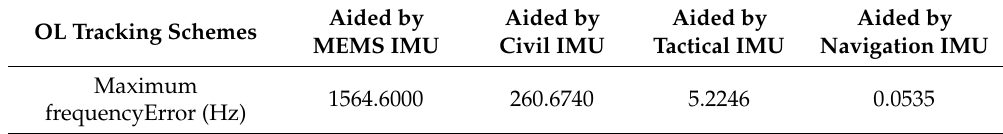
Table 5. The Doppler estimation errors of four OL tracking schemes with a drift time of 270